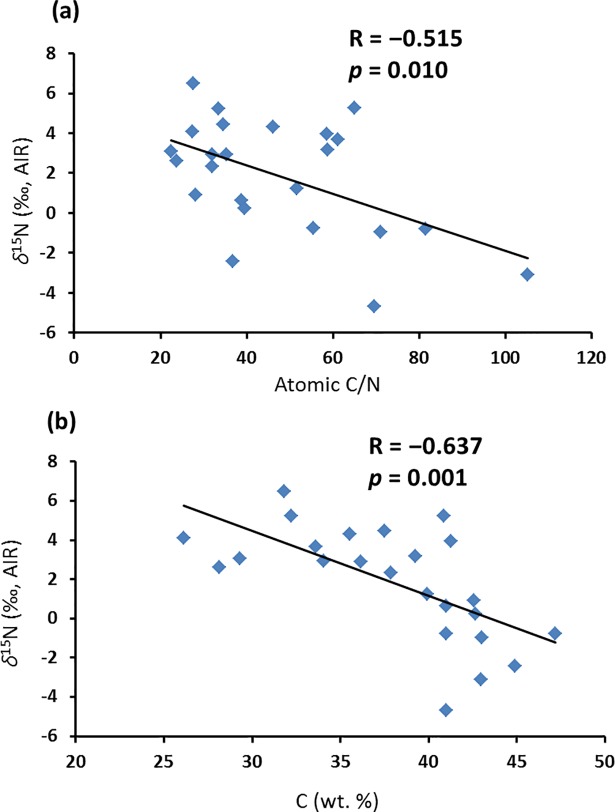
Bivariate plot of (a) δ15N vs. atomic C/N, and (b) δ15N vs. C (wt. %) of decomposed plant debris.